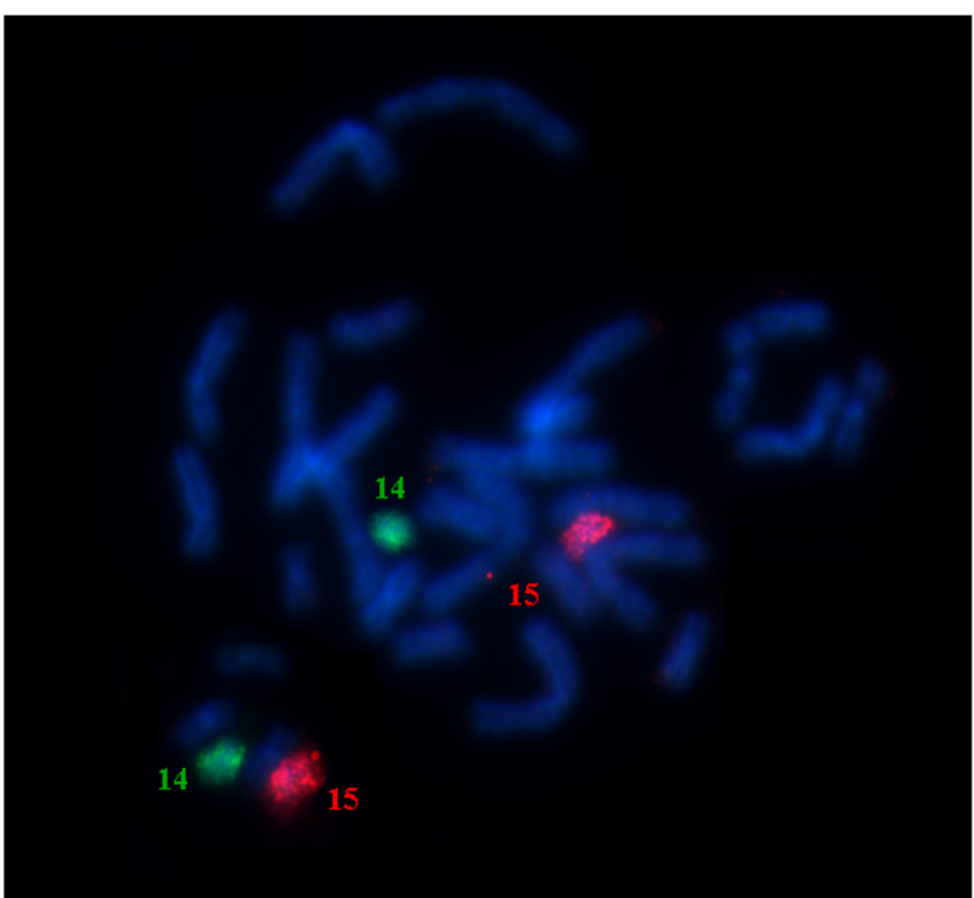
Fig 4. Whole chromosome probes FISH of PHA-14 (green) and PHA-15 (red) on PDI chromosomes, showing that PDI chromosomes are homologous to both PHA whole chromosomes their despite of metacentric form.